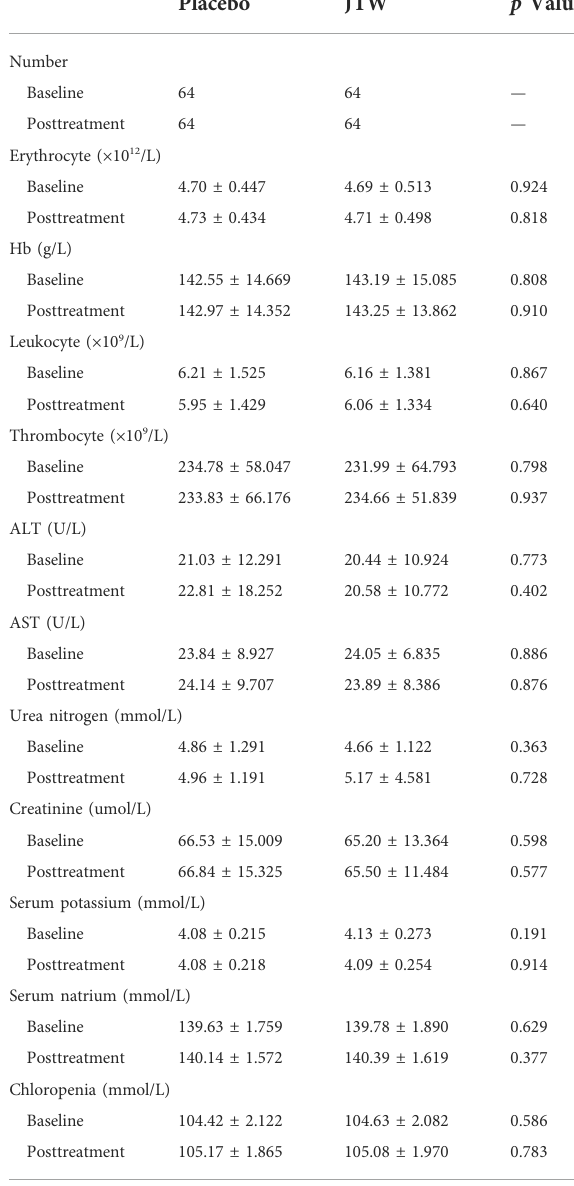
TABLE 7 Blood routine test and blood biochemical test in the participants at baseline and posttreatment between the JTW and placebo